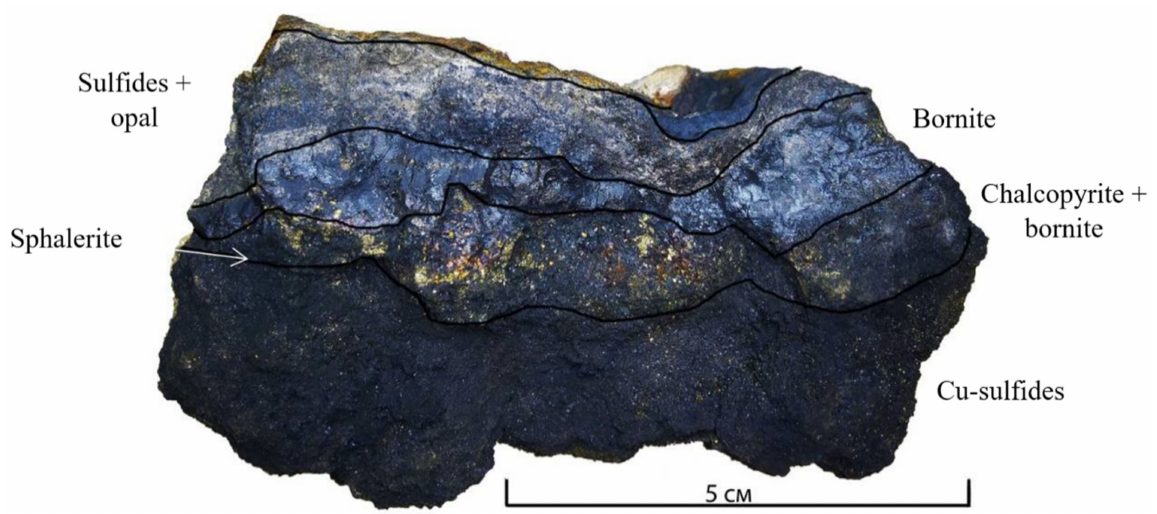
Figure 13. Fragment of the wall from the chimney structure. Koralovoye